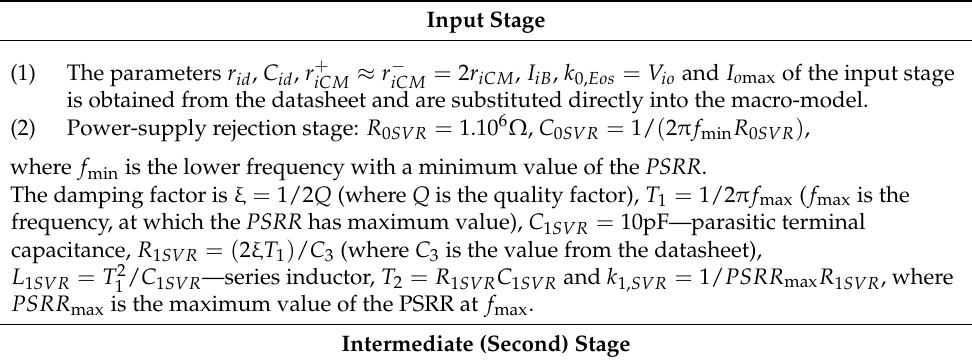
Table 2. Analytical expressions for the modeling